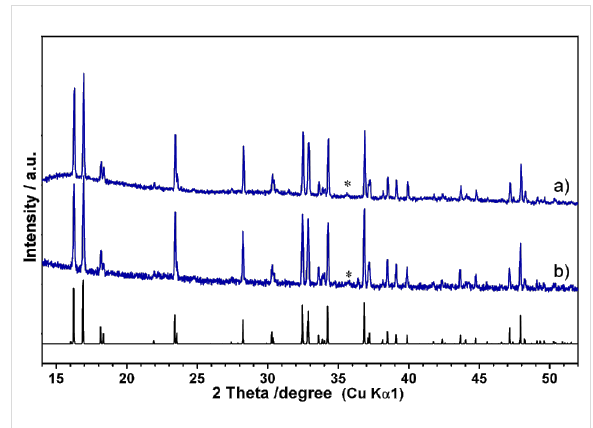
Figure 3: Powder XRD patterns of Li 2 CoPO 4 F/C (a) and Li 2 Co 0.9 Mn 0.1 PO 4 F (b). A theoretical pattern of Li 2 CoPO 4 F calculated by using PDF 56-149 is shown on the bottom. Reflections corres- ponding to WC are marked by an